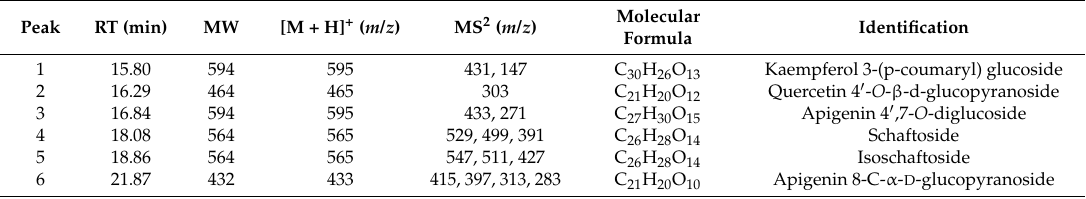
Figure 2. Total ion chromatogram and HPLC chromatogram of Fr3-3 by LC-MS/MS. Table 2. Mass spectral data positive Table 2. Mass spectral data positive mode.